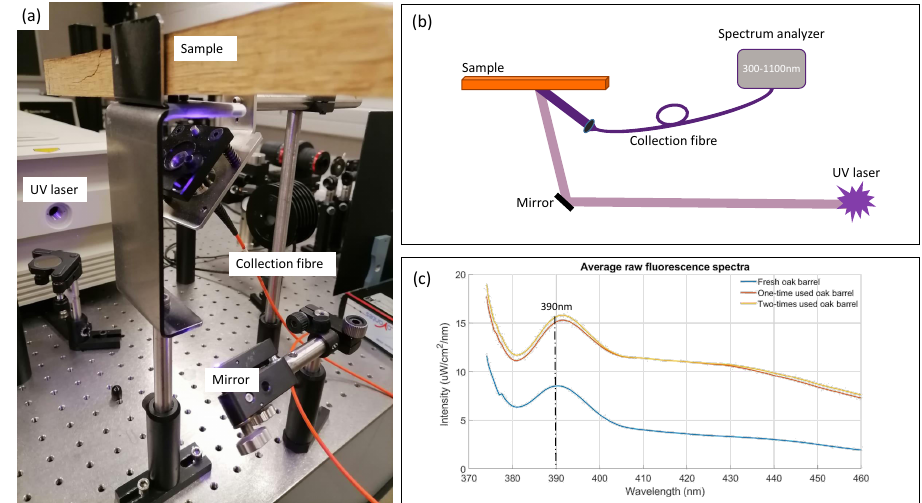
Figure 2. Fluorescence spectroscopy measurement setup. ( a ) Experimental setup. An excitation laser, detection fibre, and spectrum analyzer are used to capture the weak fluorescence intensity of the oak samples. ( b ) Schematic overview. ( c ) Raw fluorescence spectra of three oak samples. The peak at 390 nm represents the autofluorescence emission maximum of